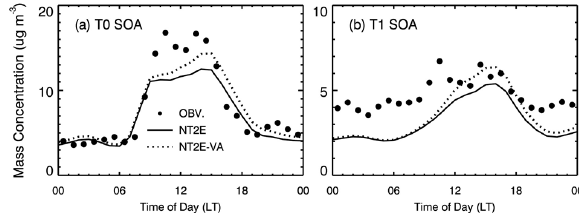
Fig. 14. Diurnal cycles of SOA (a) T0 and (b) at T1 averaged during the period from 24 to 29 March 2006. Black dots: measurements; black solid line: the NT2E-SOA model; black dotted line: NT2E- SOA model with the aging of the organic condensable gases from the oxidation of anthropogenic precursors.